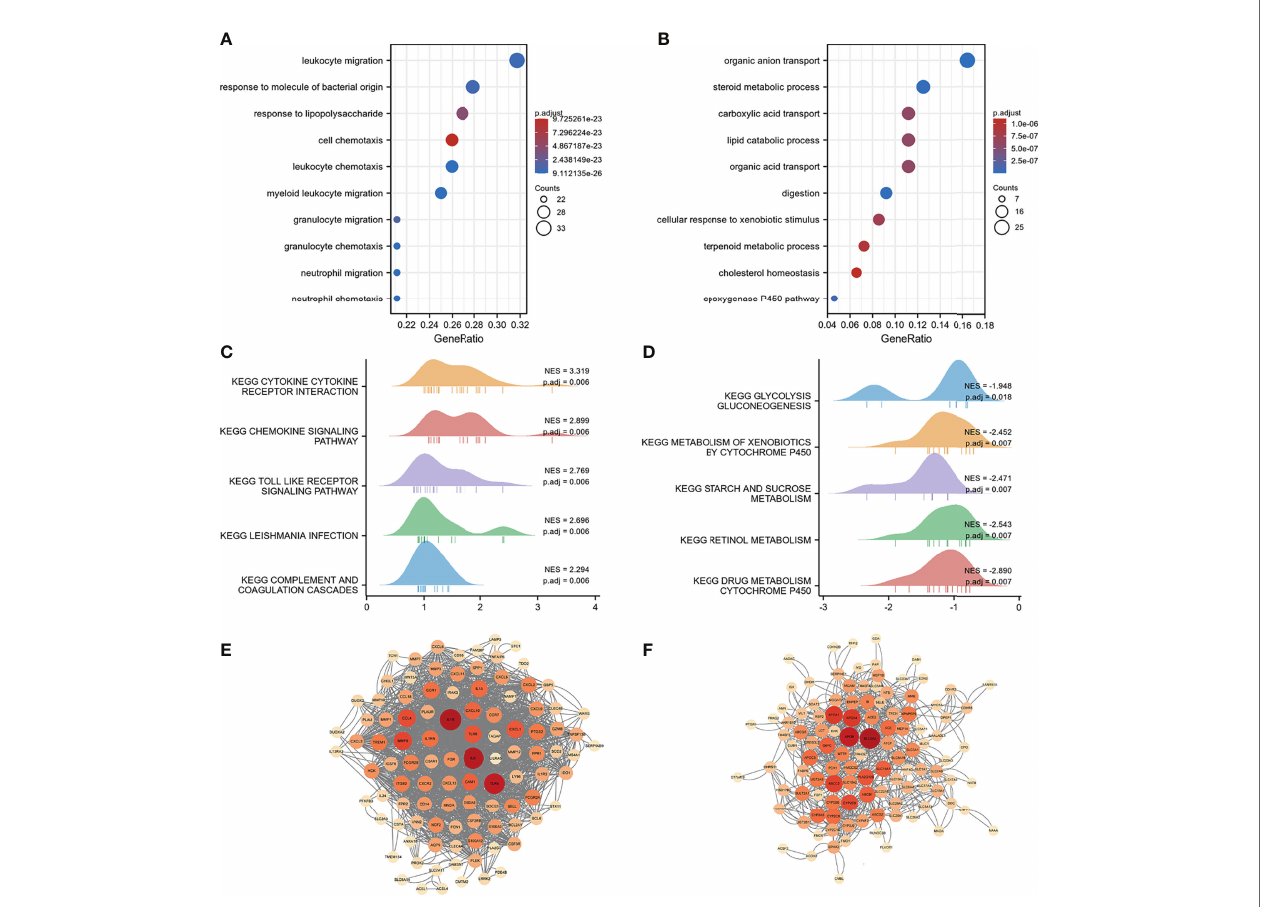
FIGURE 7 | Functional enrichment and PPI networks. (A) Top 10 GO BP of gene subtype A. (B) Top 10 GO BP of gene subtype B. (C) Top 10 GSEA enrichments of gene subtypeA. (D) Top 10 GSEA enrichments of gene subtype B. (E) PPI networksof representative DEGs ofgene subtype A. (F) PPI networks of representative DEGs of gene subtypeB.Light color represents low-degree mapping, whereas dark color represents high-degree